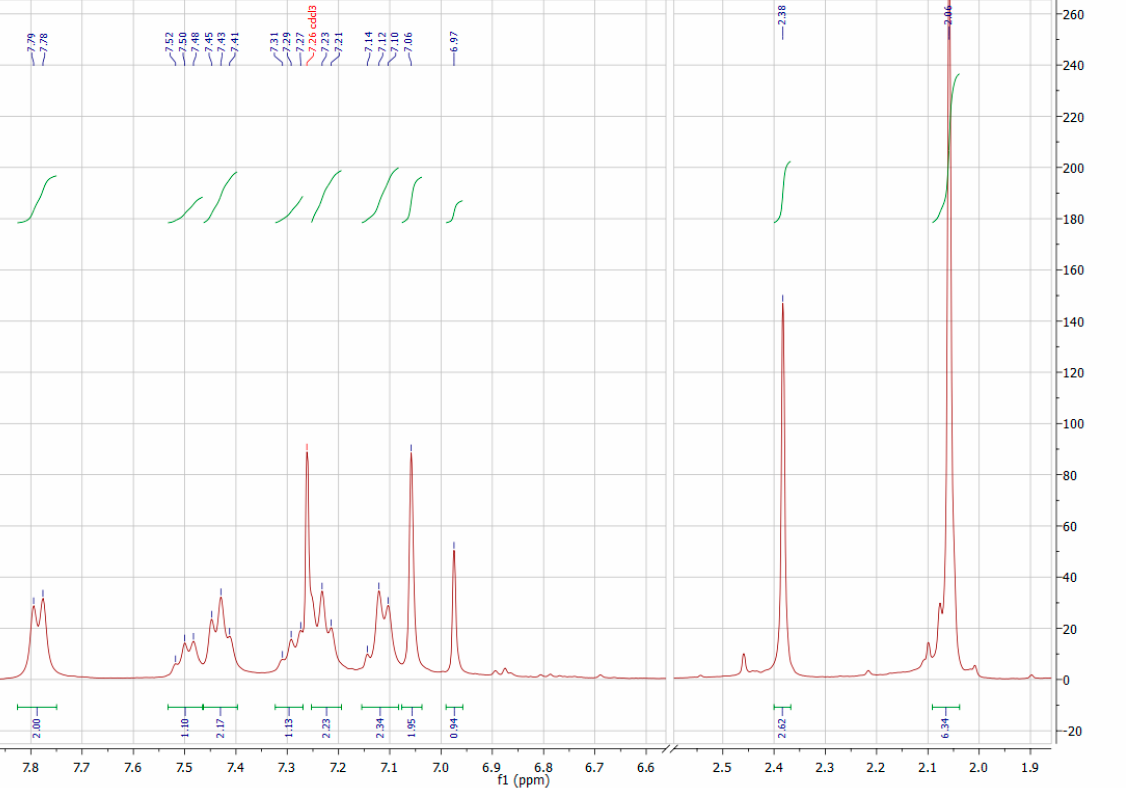
Figure A5. NMR Spectrum (400 MHz) of ( L3 ) in CDCl 3